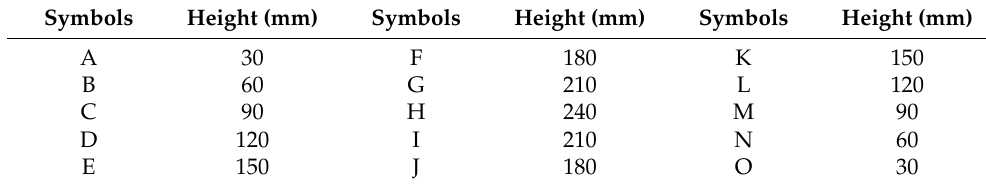
Table 6. The heights of the obstacles.